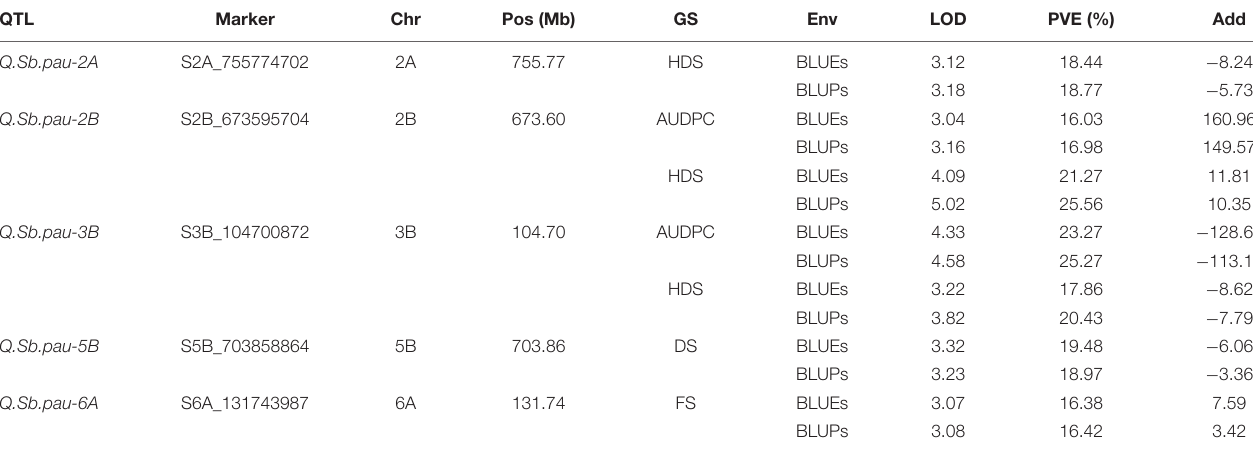
TABLE 2 | Summary of the QTLs detected using both single marker analysis (SMA) and RSTEP-LRT for additive effect of markers algorithms of QTL ICI mapping for spot blotch disease severity. QTL Marker Chr Pos (Mb) GS Env LOD PVE (%) Add